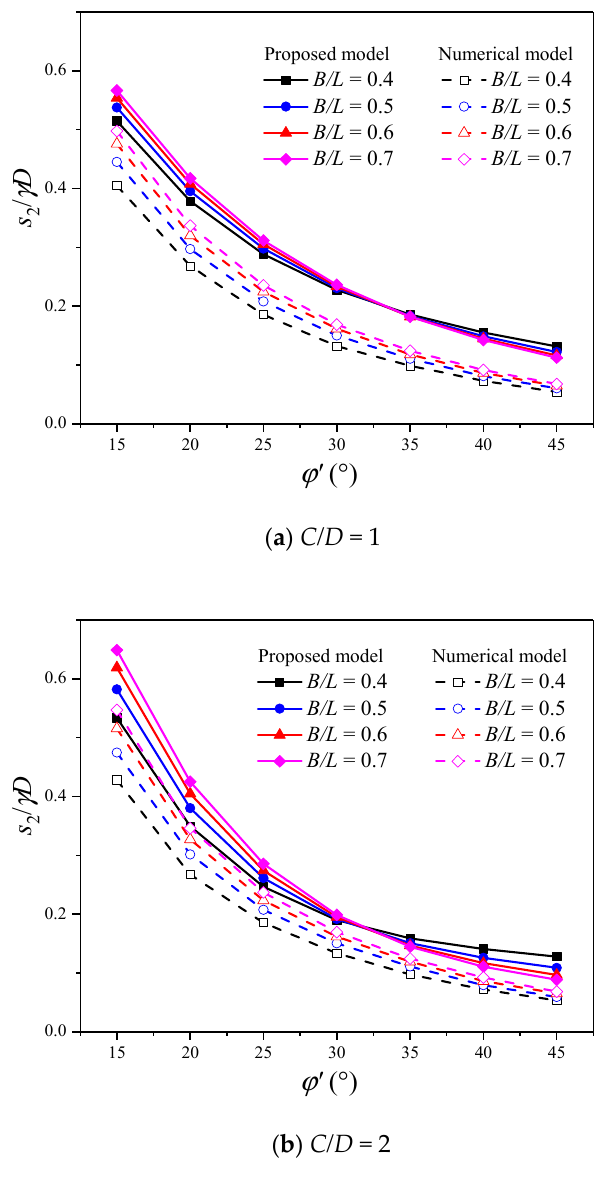
( b ) C/D = 2 (cid:48) . s D γ depending on ϕ′ . Figure 8. Variations in s Figure 8. Variations in 2 / γ D depending on ϕ 2 Figure 9 shows the variation in S 2 depending on B / L for a typical ϕ (cid:48) = 25 ◦ and L / D = 2. S 2 grows rapidly with an increasing B / L ; the change curve is steep, and the range of change is large. Figure 10 shows the variation in s 2 / γ D depending on B / L for a typical ϕ (cid:48) = 25 ◦ . In Figure 10a ( C / D = 1), both models predict that s 2 / γ D increases with an increasing B / L . The curves are relatively flat with less variation. Comparing Figures 9 and 10, it can be found that under the same conditions, S 2 increases by almost 100%, while s 2 / γ D increases by approximately 10%. Due to s 2 = S 2 / BD (Equation (15)), the change in s 2 / γ D is related to B when γ D is constant. When the increase in S 2